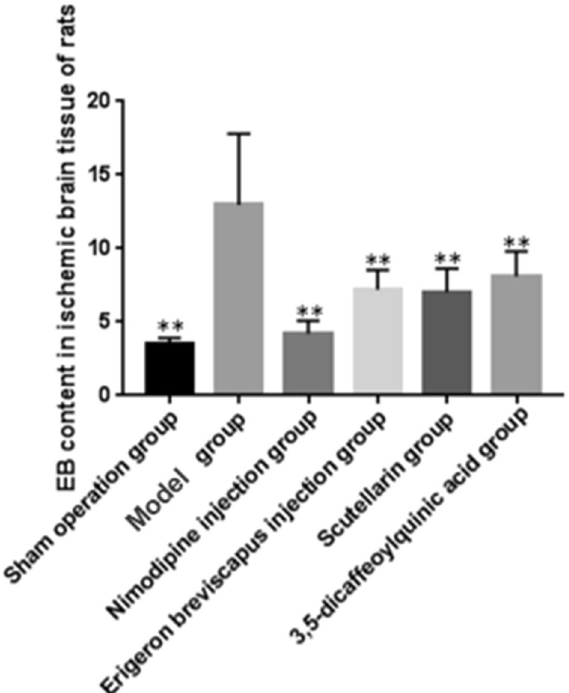
Figure 8. BBB permeability in the ischemic brain tissue of rats. The values are presented as mean ± SD. (n = 6), * compared with the model group, * P < 0.05 and ** P <